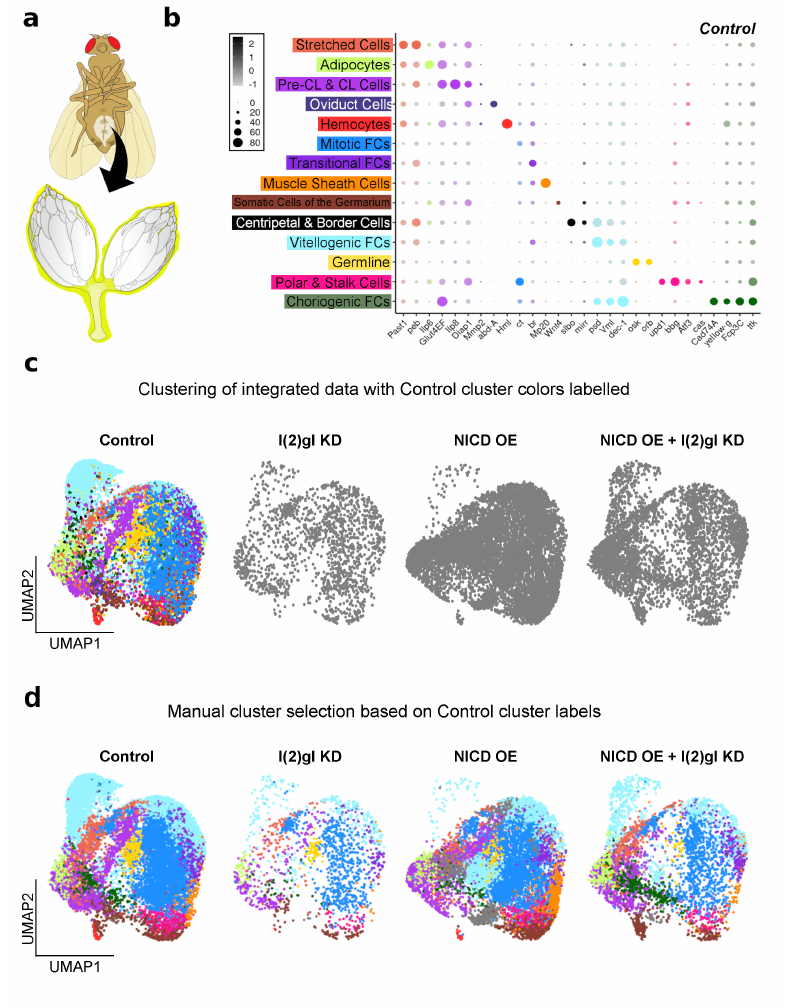
Figure 6. Single-cell RNA sequencing of tumorigenic follicle cells. ( a ) An illustration of sample collection. Entire ovaries and interconnected oviduct tissue (highlighted in yellow) was sampled for sequencing. ( b ) Dot plot showing the known marker genes used to identify the cell types in each control cluster. Average expression (from − 1 to 2 LogFC) and percentage of cells expressing each marker (from 0 to 80%) is shown. ( c ) UMAP plot showing single cells (dots) clustered together by shared RNA expression profile. Clusters identified (and colored) in b are shown in the control dataset which was integrated with the other 3 datasets and clustered together (shown in gray). ( d ) Clusters were manually selected based on the cell identities shown in c and colored to compare cluster type between all genotypes. As expected clusters with late-stage follicle cell sub-types such as Vitellogenic and Choriogenic follicle cells (FCs) are reduced in the l(2)gl KD sample. The NICD OE sample has three unique clusters that could not be identified and remain in